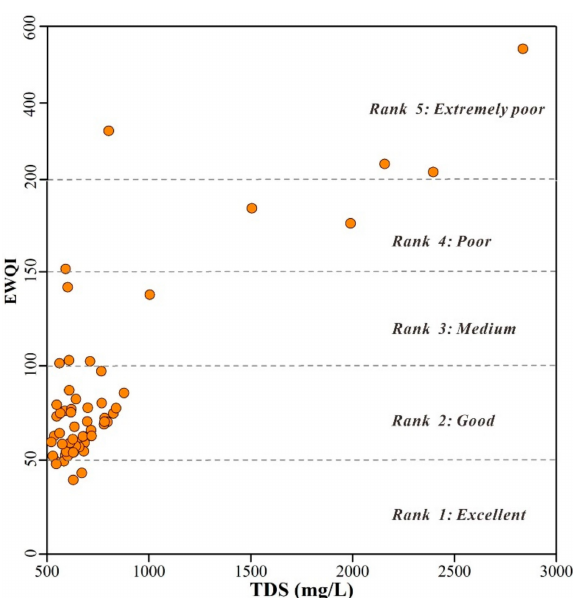
Figure 5. Scatter plot of the TDS versus entropy-weighted water quality index (EWQI) of groundwater.